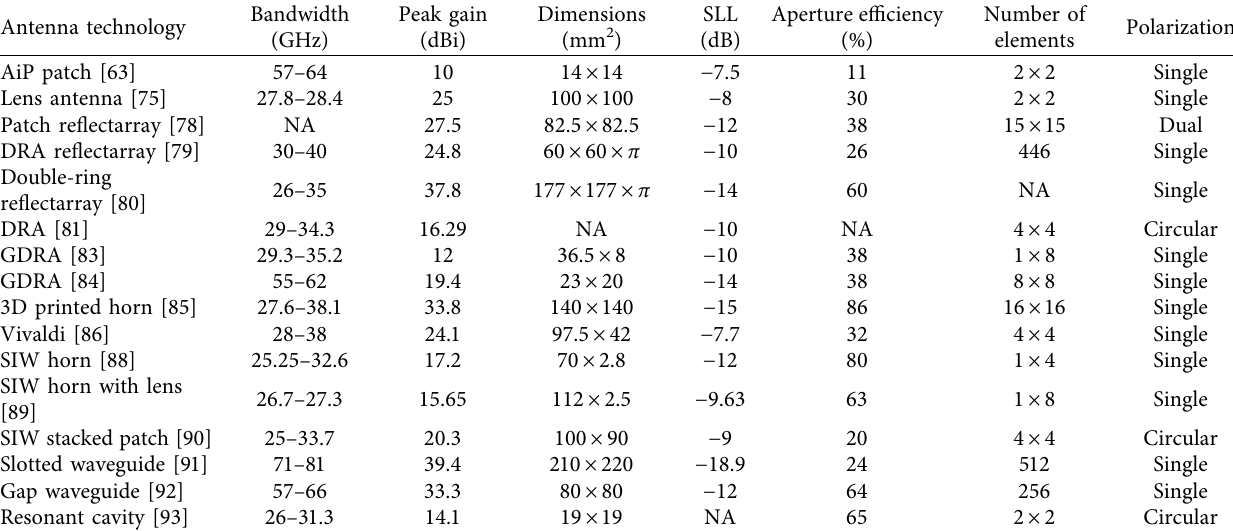
Table 3: State of the art of high-gain array-based antenna concepts for PtP mm-wave wireless communications. Antenna